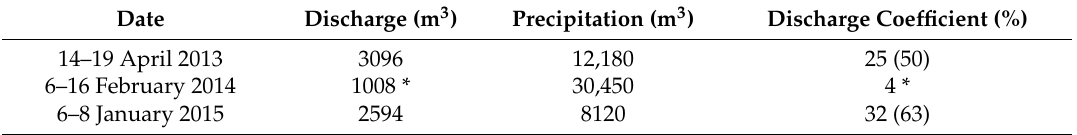
Table 3. Start and end date of the rain events of interest with measured surface discharge, precipitation per area and percentage of precipitation water, which reached the outlet (discharge coefficient) for these rain events. Values in parenthesis show the discharge coefficient for the agricultural area only (no forest). Values marked with an asterisk (*) are incorrect measurements due to the by-pass of water below the flume.